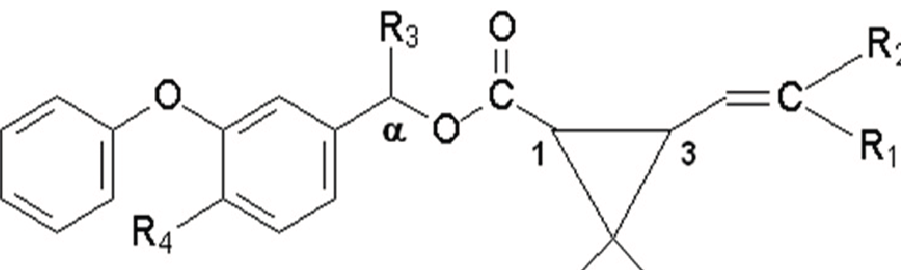
Figure 1. General structure of the pyrethroids included in the study.